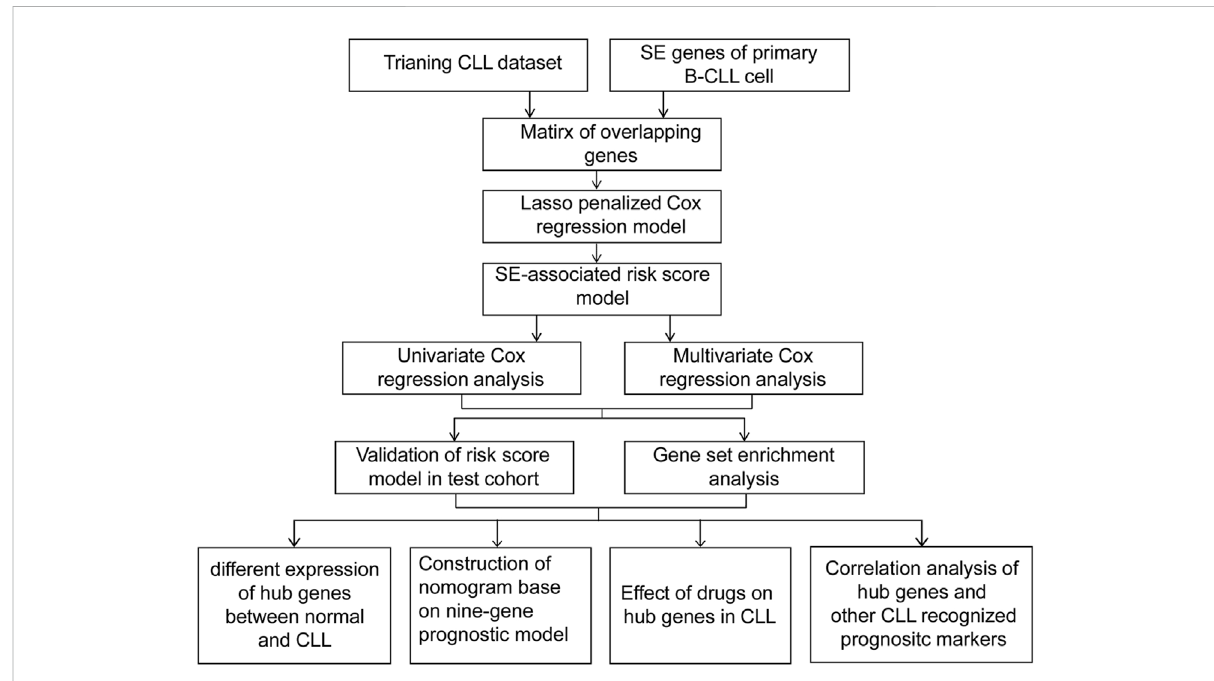
FIGURE 1 A fl owchart of the overall procedure used to establish and verify the SE-associated gene-based prognostic model in CLL